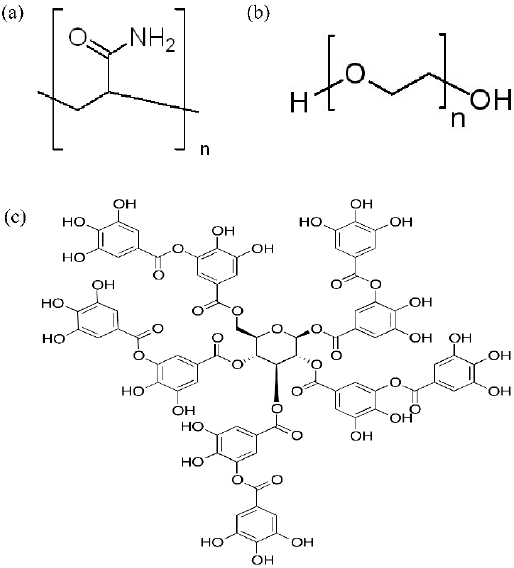
Figure 2. Molecule structure: ( a ) PAM; ( b ) PEO; ( c ) TA.